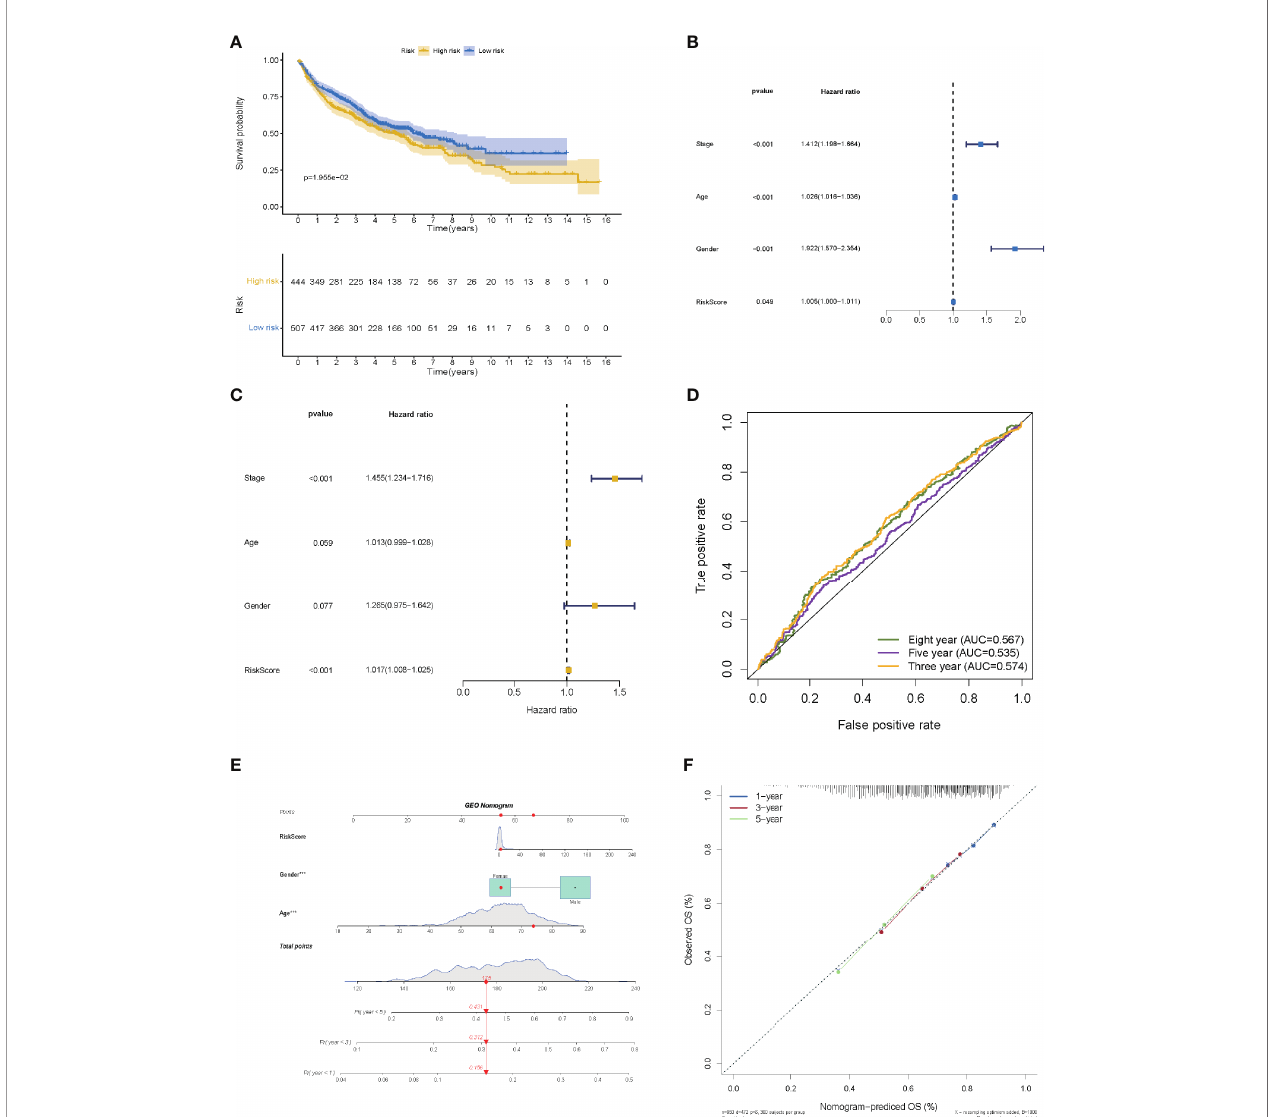
FIGURE 6 | The validation of a prognostic signature of LMR-lncRNAs in a validation cohort. (A) The KM curves of the validation cohort demonstrated signi fi cant differences in OS between the low- and high- risk groups ( P < 0.05). COX regressions for the LMR-lncRNA signature developed from the training cohort are shown in univariate (B) and multivariate (C) analyses. (D) The AUC of ROC curves corroborated the prediction performance levels of the LMR-lncRNA signature in the validation cohort. (E) A nomogram based on clinical characteristics (e.g., the risk score) and patient survival. (F) The calibration chart to determine the consistency of the anticipated and actual 1-, 3-, and 5- year survival